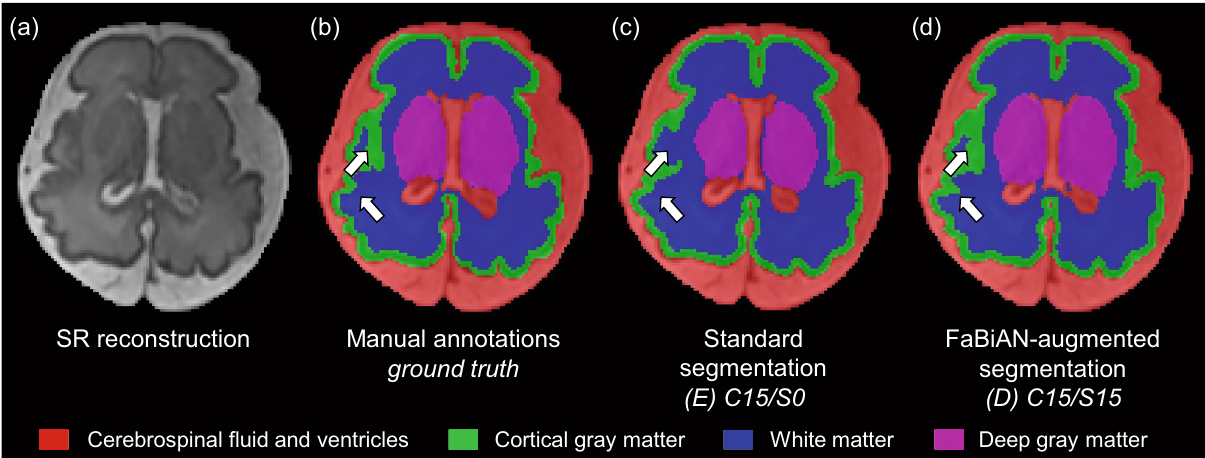
Figure 7. Illustration of the accuracy of fetal brain tissue segmentation in a subject of 30.6 weeks of GA on ( a ) an axial slice from the SR reconstruction. Comparison of ( b ) the reference manual annotations, ( c ) the segmentation results obtained when performing extensive standard data augmentation on the clinical SR reconstructions (configuration ( E ), C15/S0), ( d ) the segmentation results obtained by the configuration ( D ) that complements this original dataset with fifteen additional simulated subjects (C15/S15), overlaid on the SR image. The segmentation of the cortex especially looks more accurate in ( d ), with an increased sensitivity to folding as highlighted by the white